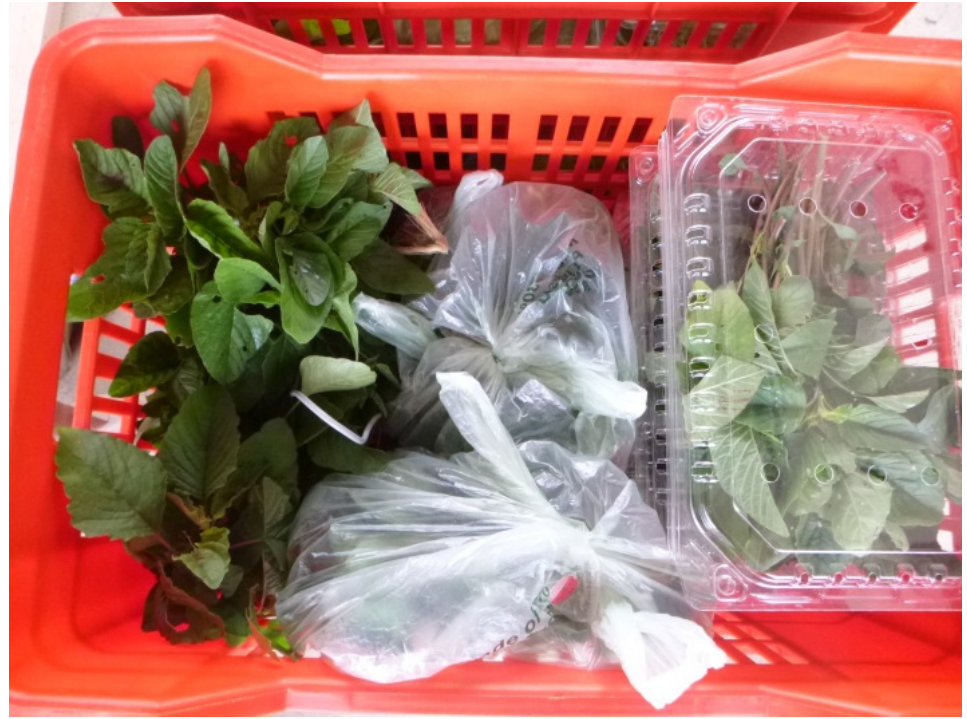
Figure 1. Arrangement of four replicates of three different consumer containers (left to right: bunches, plastic bags and clamshells) in each returnable plastic